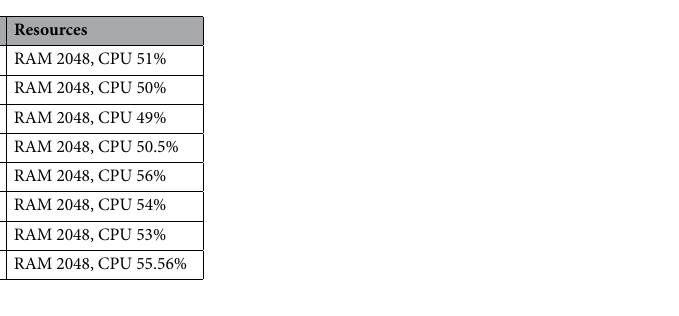
Table 2. Metrics